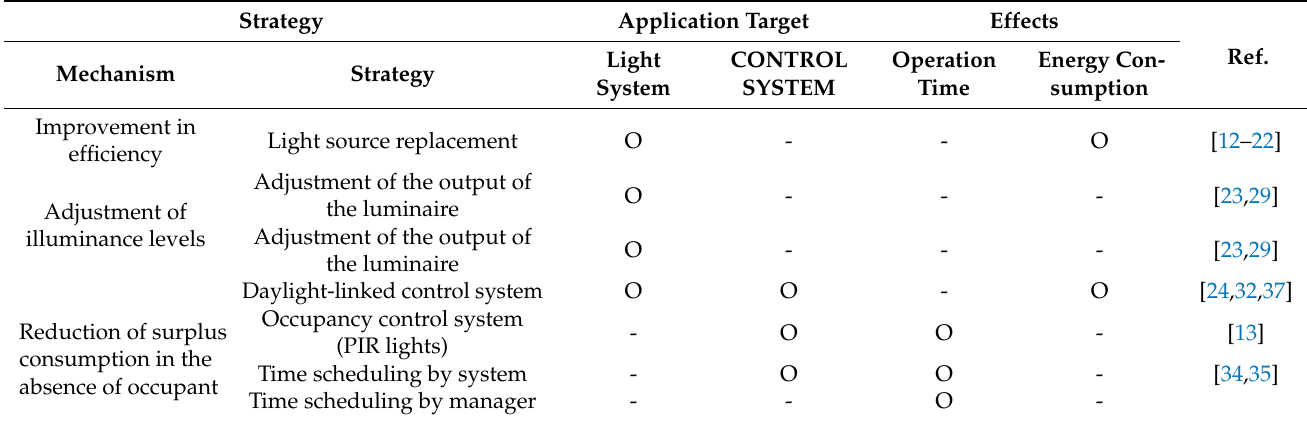
Table 1. Representative energy saving